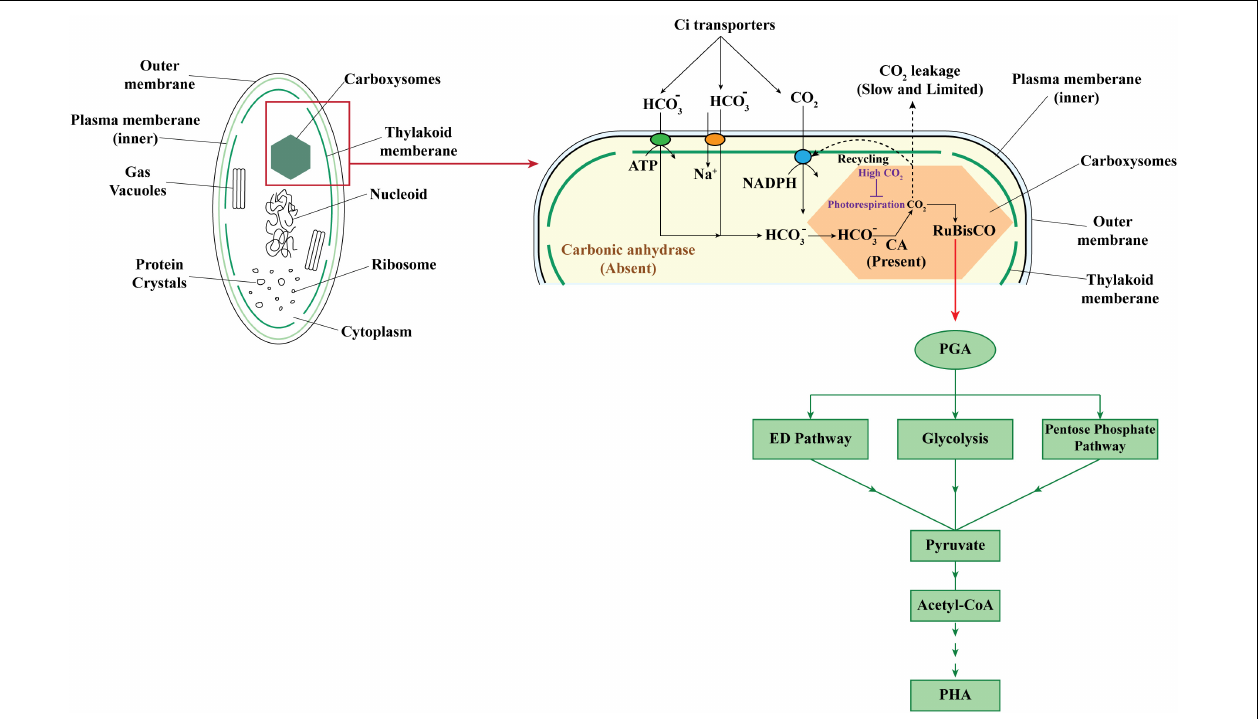
FIGURE 2 | Carbon concentrating mechanism in cyanobacteria for CO 2 fixation and further conversion to PHA.